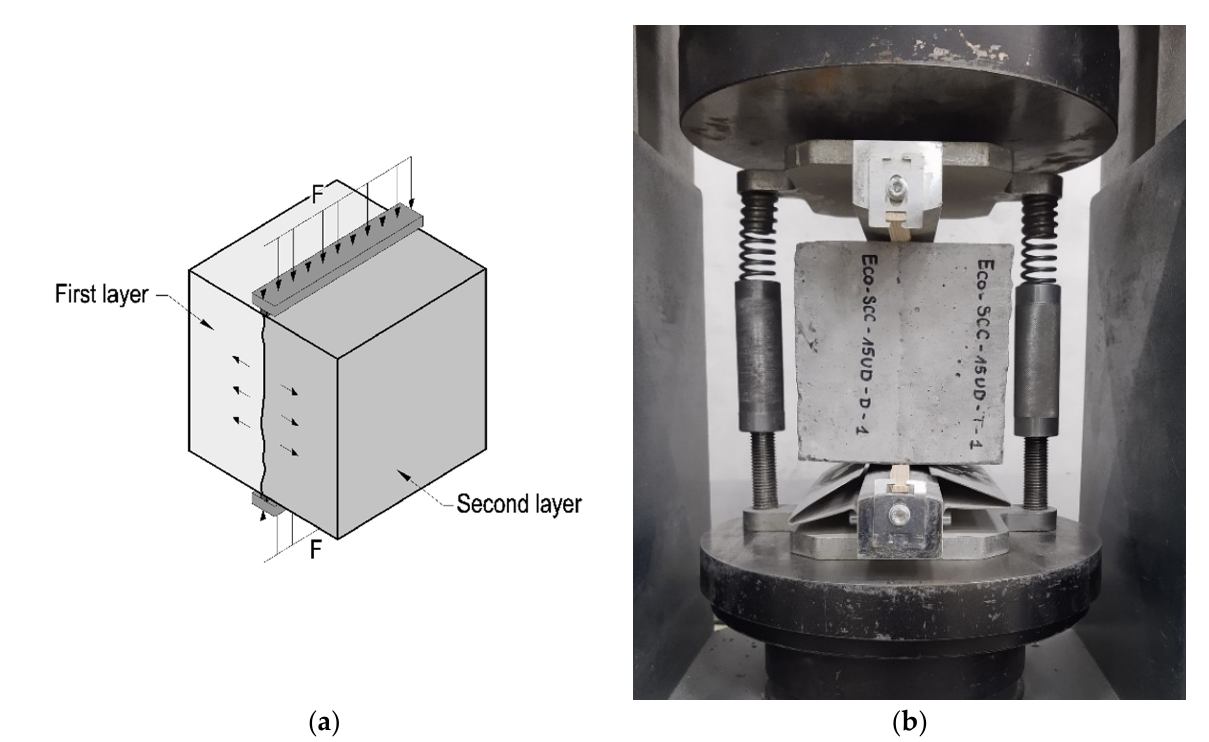
Figure 2. A view of: ( a ) sketch of test setup; ( b ) test of bond strength on typical sample.